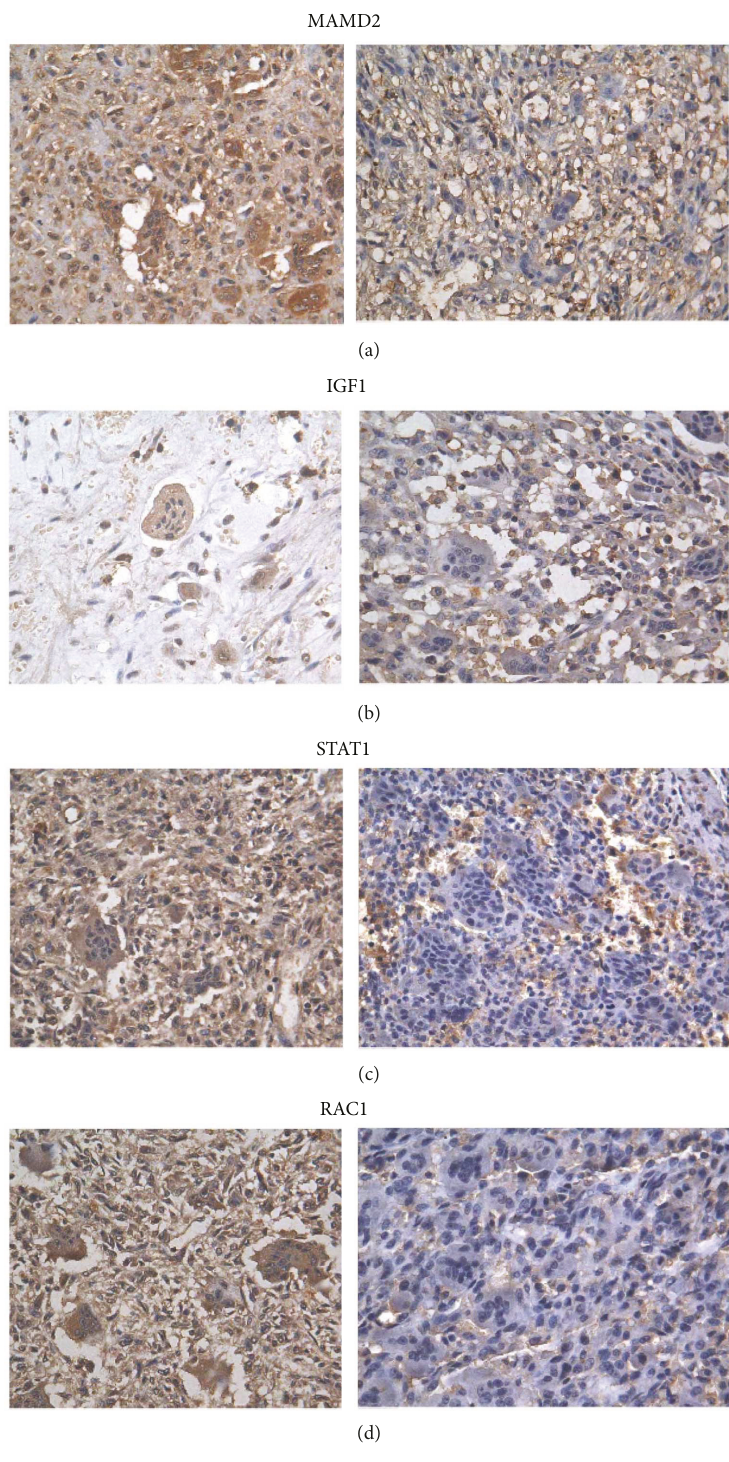
Figure 1: Expression of MDM2, IGF1, STAT1, and RAC1 in GCT tissues (400X, scale bar =50 μ m). (a) Expression of MDM2. Positive staining of MDM2 in the tumor tissue of a recurrent GCT (left). Negative staining of MDM2 in the tissue of a primary GCT from a patient without recurrence (right). (b) Positive staining of IGF1 in the tumor tissue of recurrent GCT (left). Negative staining of IGF1 in the primary tumor tissue of a GCT patient without recurrence (right). (c) Positive staining of STAT1 in the tumor tissue of recurrence GCT (left). Negative staining of STAT1 in the primary tumor tissue of a GCT patient without recurrence (right). (d) Positive staining of RAC1 in the tumor tissue of recurrence GCT (left). Negative staining of RAC1 in the tumor tissue of primary GCT without recurrence (right). Positive staining for all genes was located in the cytoplasm and nuclei of multinucleated giant cells and mononuclear stromal